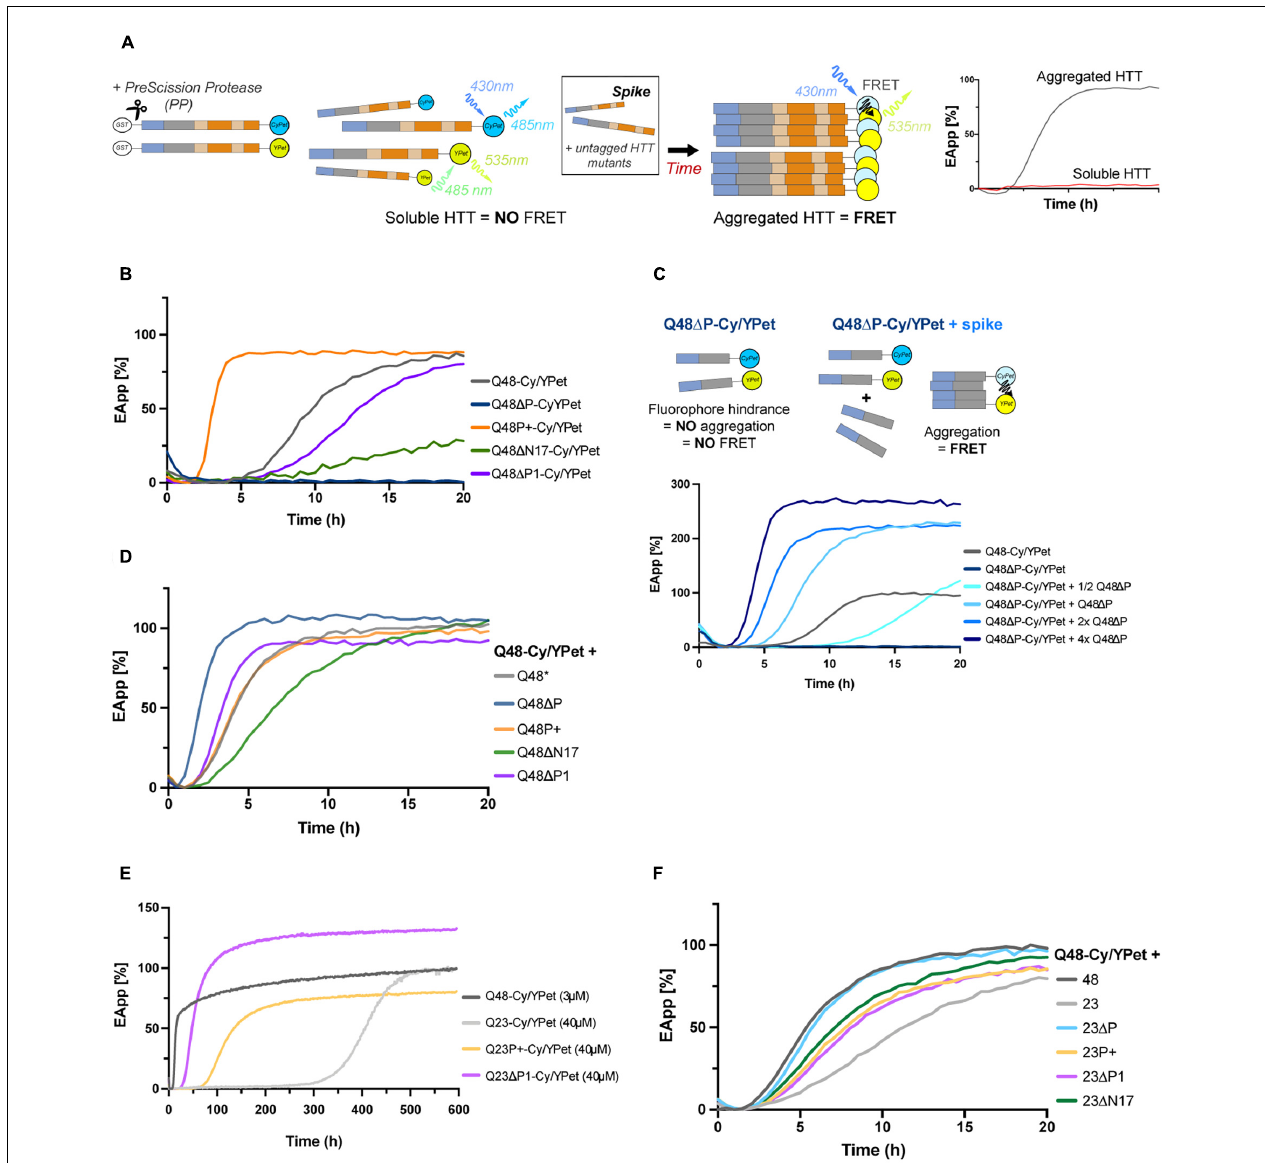
FIGURE 3 | Deletion or expansion of PRD facilitates aggregation even for short polyQ variants. (A) Schematic of the FRET-based aggregation assay: upon addition of PP, CyPet/YPet tagged HTTEx1 mutants initiate aggregation, generating a readable and increasing FRET signal. In some experiments, the CyPet/YPet-tagged HTTEx1 moieties are mixed with non-tagged mutant HTTEx1, or ‘spiked.’ A fully aggregated reaction will be illustrated by a sigmoidal curve reaching a plateau over time, while soluble moieties will appear as flat lines. (B) FRET analysis of HTTEx1 mutants individually tagged with CyPet/YPet. The FRET signal of the non-variated Q48-CyPet/YPet serves as control (gray line). (C) FRET analysis of (cid:49) P mutants: due to the steric hindrance imposed by the fluorophores (as illustrated in the cartoon schematic), readable FRET signals only appears when Q48 (cid:49) P-CyPet/YPet pair is spiked with untagged (cid:49) P, with faster kinetics with increasing untagged Q48 (cid:49) P concentration. (D) FRET analysis of non-variated Q48-CyPet/YPet spiked with equimolar amounts of non-tagged HTTEx1 mutants with Q48-CyPet/YPet. Lag phases are shifted closer to each other (compare to (B) ). (E). FRET analysis of the aggregation of selected HTTEx1 mutants expressing the physiological Q23. Aggregation of these Q23 mutants were also compared to non-variated Q48-CyPet/YPet control (gray line). (F) FRET analysis of non-variated Q48-CyPet/YPet spiked with equimolar amount of HTTEx1 mutants with physiological Q23. Unless stated in the legends, final concentration for each reaction is 3 µ M. All results are representative of at least three independent